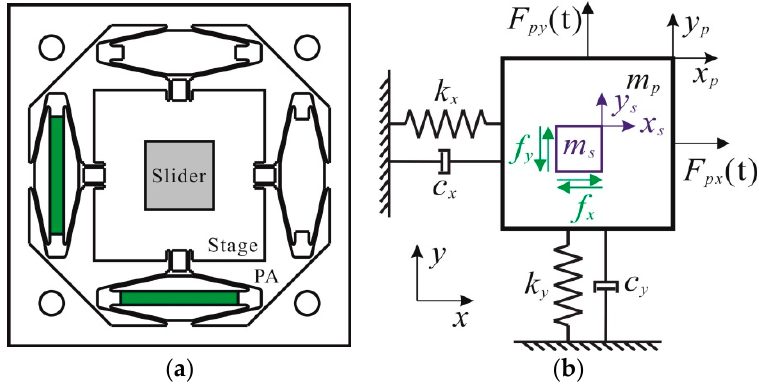
Figure 1. A two-degrees-of-freedom (2-DOF) linear piezoelectric impact drive mechanism (PIDM): ( a ) Schematic diagram; ( b ) Simplified system.